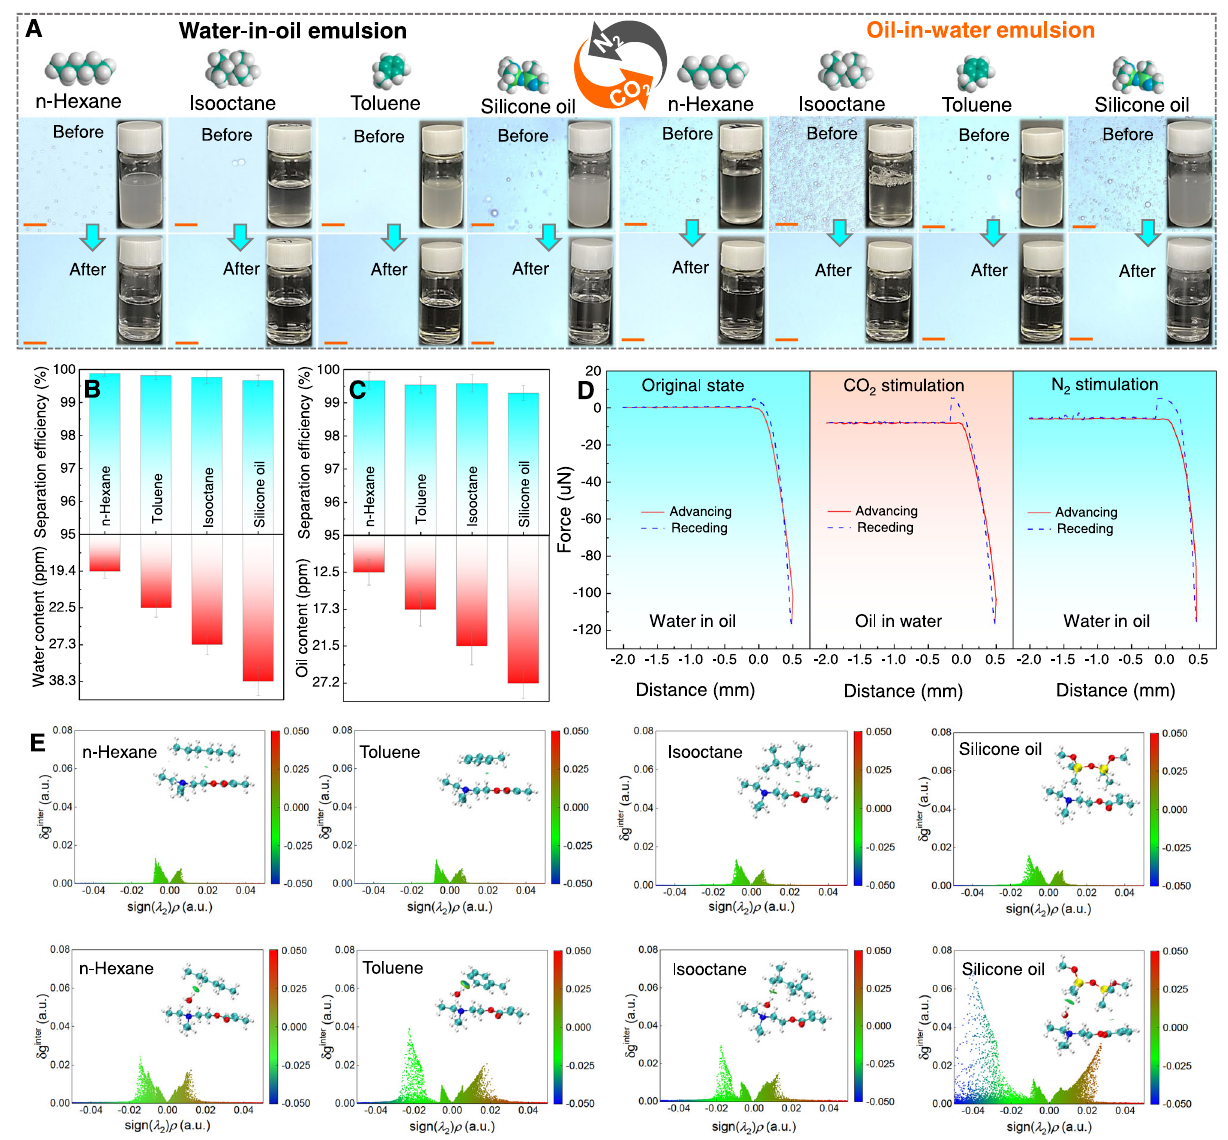
Fig. 4 | Gas switchable emulsion separation. A Photographs of various O/W and W/O emulsions under CO 2 /N 2 stimulation and the corresponding optical micro- scopic images. The scale bar is 20 μ m. B , C Separation ef fi ciency and oil or water contentofPPFM-0.5withgapwidthof150 μ mfortheW/O( B )andO/W( C )mixture systemsat25°CunderCO 2 /N 2 stimulation. D Adhesionforce-distancecurvesofthe